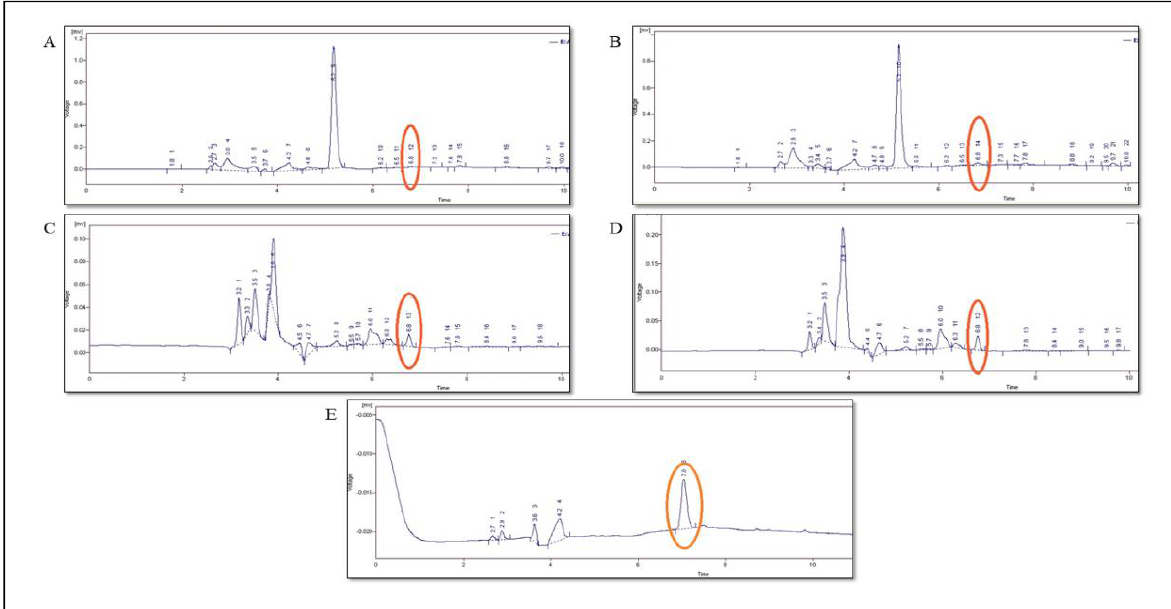
Figure 2: (A) Chromatogram of sample without any treatment (Control), (B) Chromatogram of sample with 10 µ M dose of CdCl , (C) Chromatogram of sample with 40 µ M dose of CdCl 2